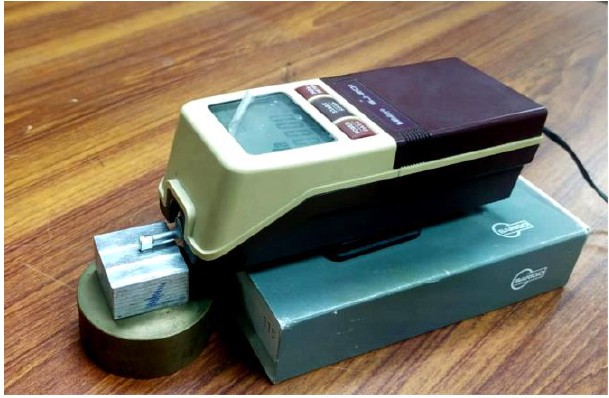
Figure 2. Surface roughness measurement.